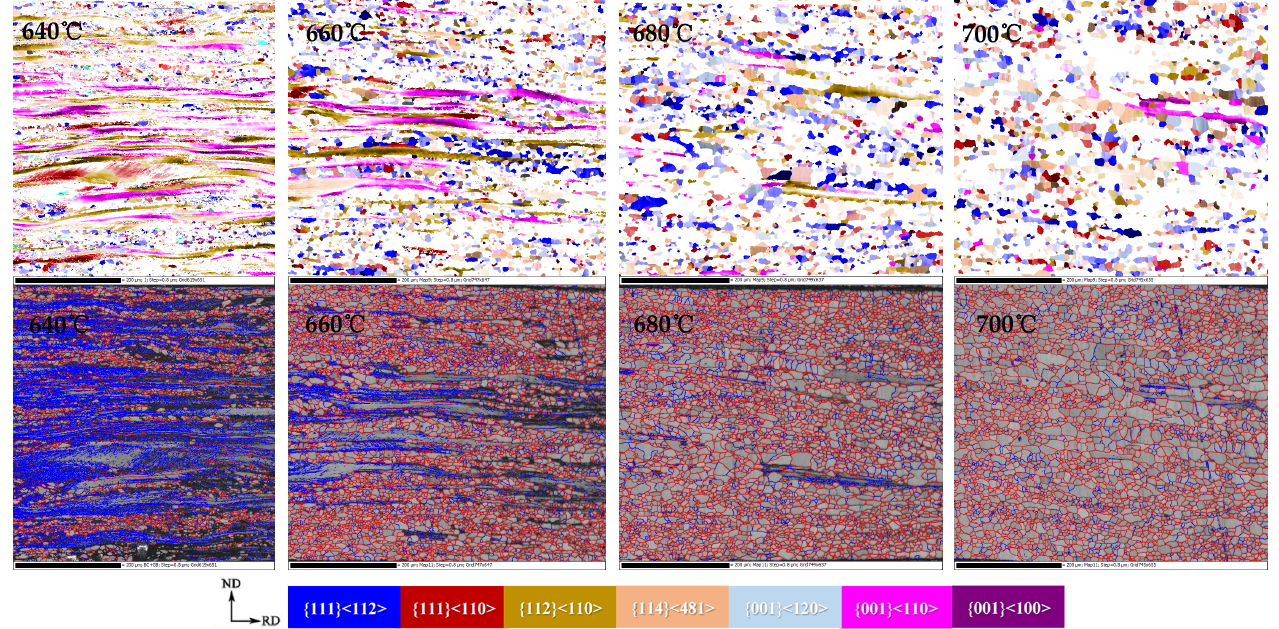
Figure 8. Textures and grain boundary distribution map of Fe-0.65%Si non-oriented electrical steel during recrystallization process.